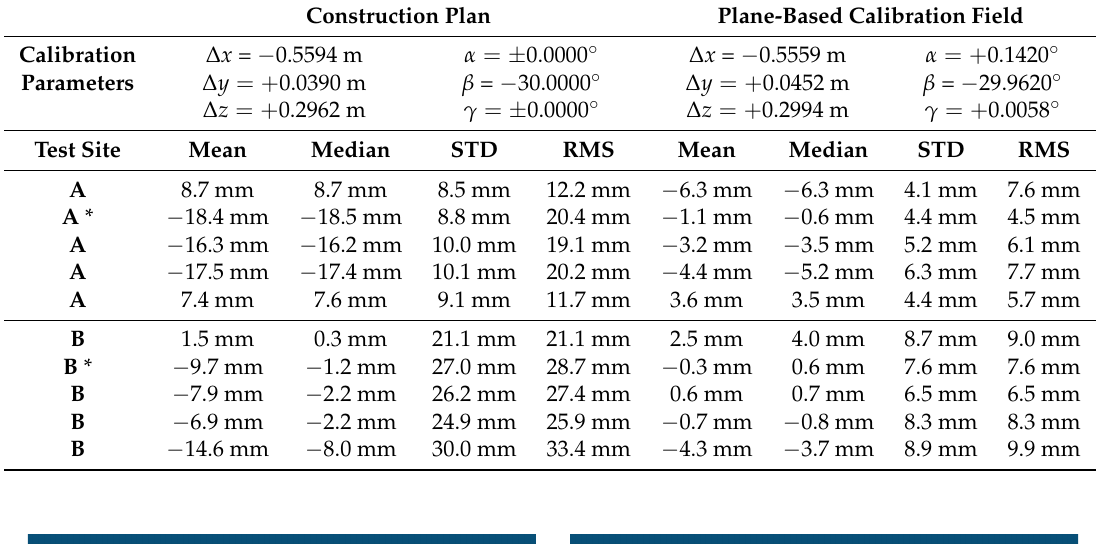
Table 5. Area-based evaluation of the mobile laser scanning system using calibration parameters from the construction plan ( left ) and from the plane-based calibration field ( right ). The table shows the mean, median, standard deviation (STD), and root mean square error (RMS) of an M3C2 comparison to a TLS reference point cloud. The rows marked with * correspond to the histograms in Figure 17.